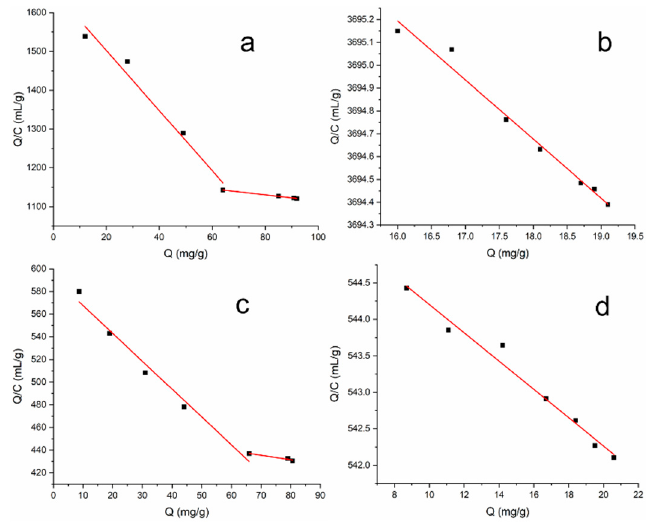
Figure 8. Scatchard fitting curve of Fe 3 O 4 @MPTES@VPBA ( a , c ) and Fe 3 O 4 @MPTES ( b , d ) for the ad ‐ sorption of adenosine ( a , b ) and o ‐ dihydroxybenzene ( c , d ).